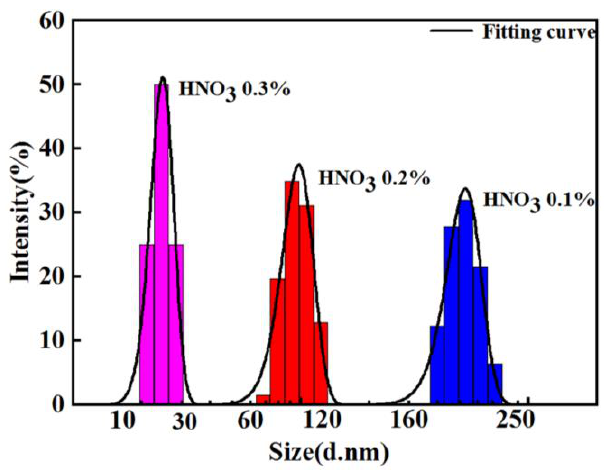
Figure 4. Particle size of coating solution with different acid content.